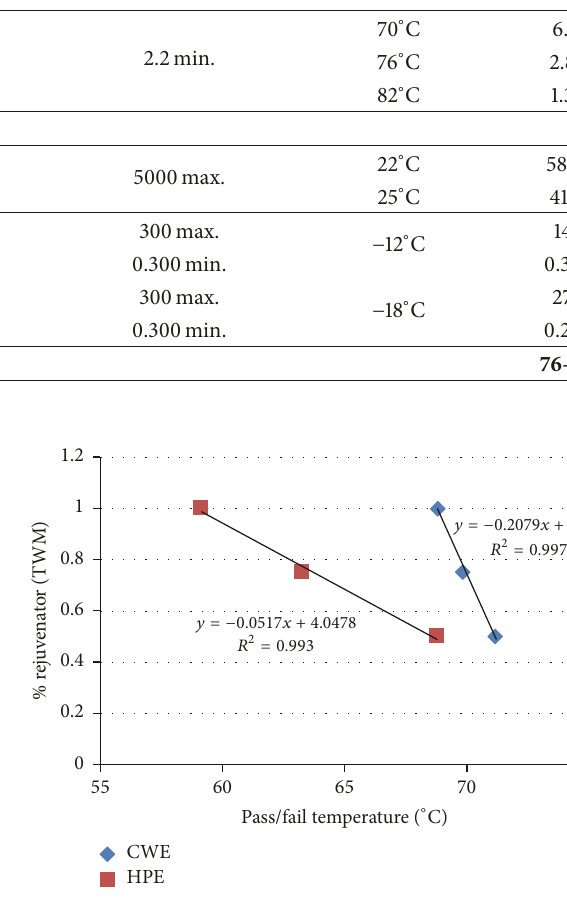
Figure 2: Softening curves of rejuvenators mixed with recovered